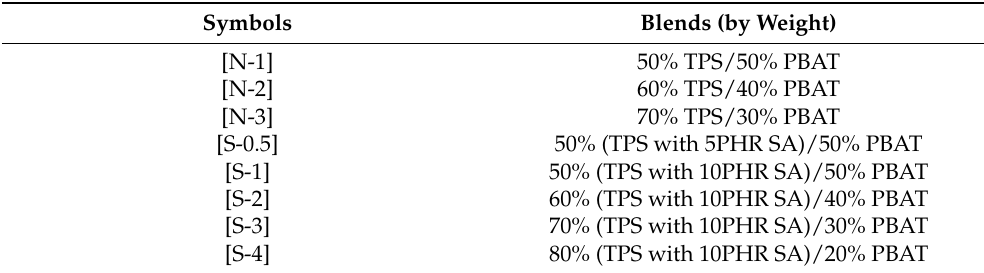
Table 1. The composite material composition ratio and symbols corresponding list.